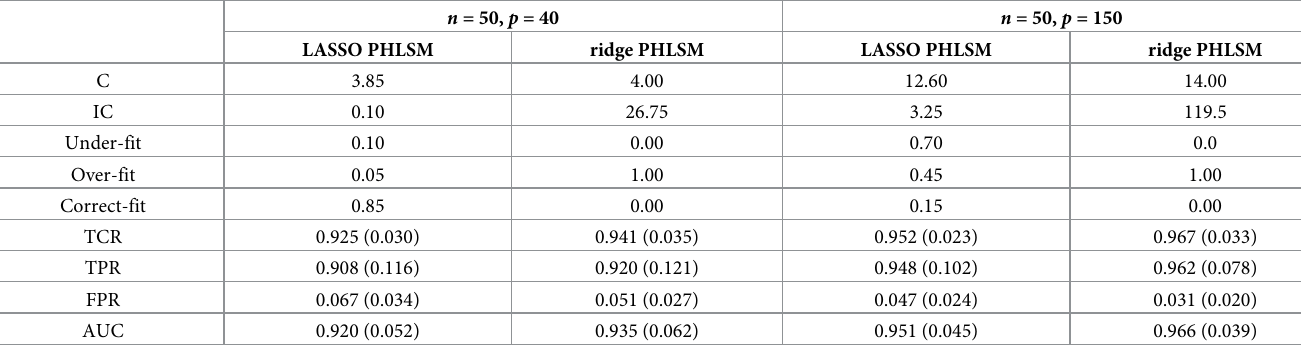
Table 5. Results for the high-dimensional covariate